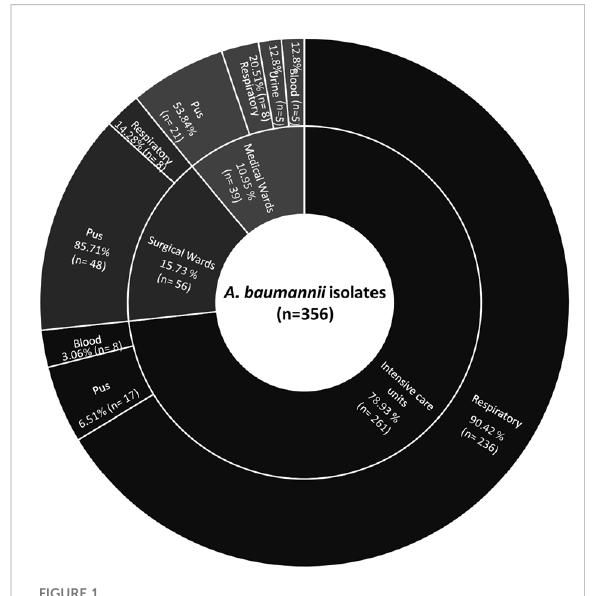
FIGURE 1 Sunburst chart showing distribution of A. baumannii isolates among different departments and clinical